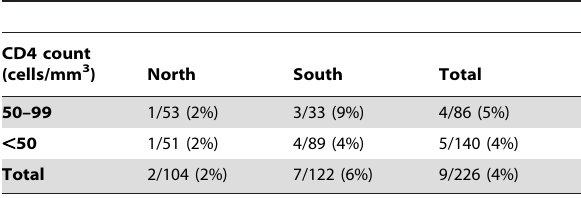
Table 3. CrAg-positive prevalence by CD4 count and region of